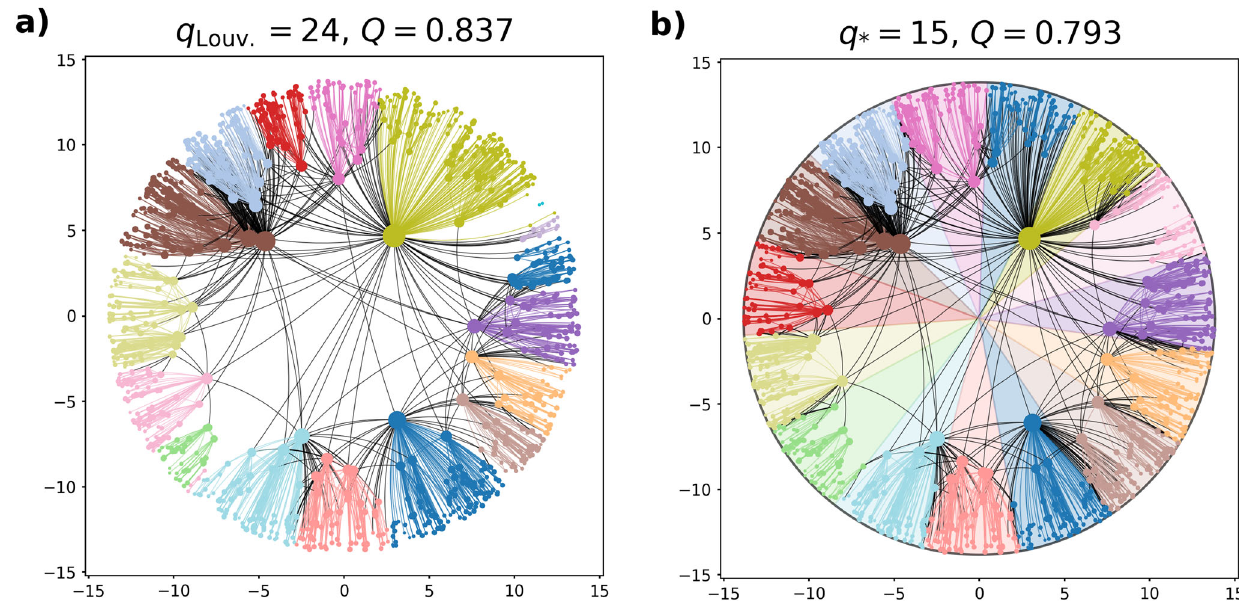
-- k ¼ 8 and N = 1000 nodes, generated at β = 0.6, T = 0.1. a The modules found by the Fig. 4 Communities in a PSO network with an average degree Louvain algorithm, indicated by colours. b The communities according to the partitioning studied in this paper, consisting of equally sized angular regions. The number of modules in this case was set to the optimal q (cid:5) ¼ C (cid:2) 1 = 2 1